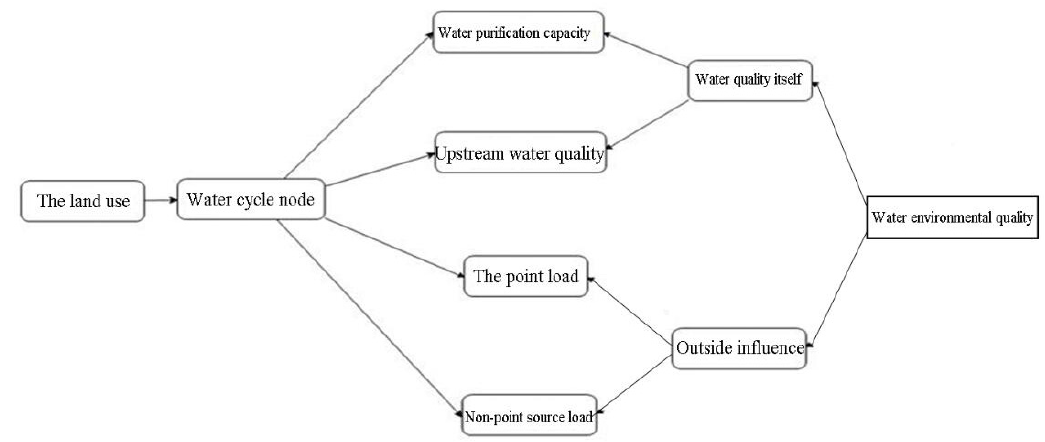
Figure 6. Influence path of land use and urban spatial planning on water quality.